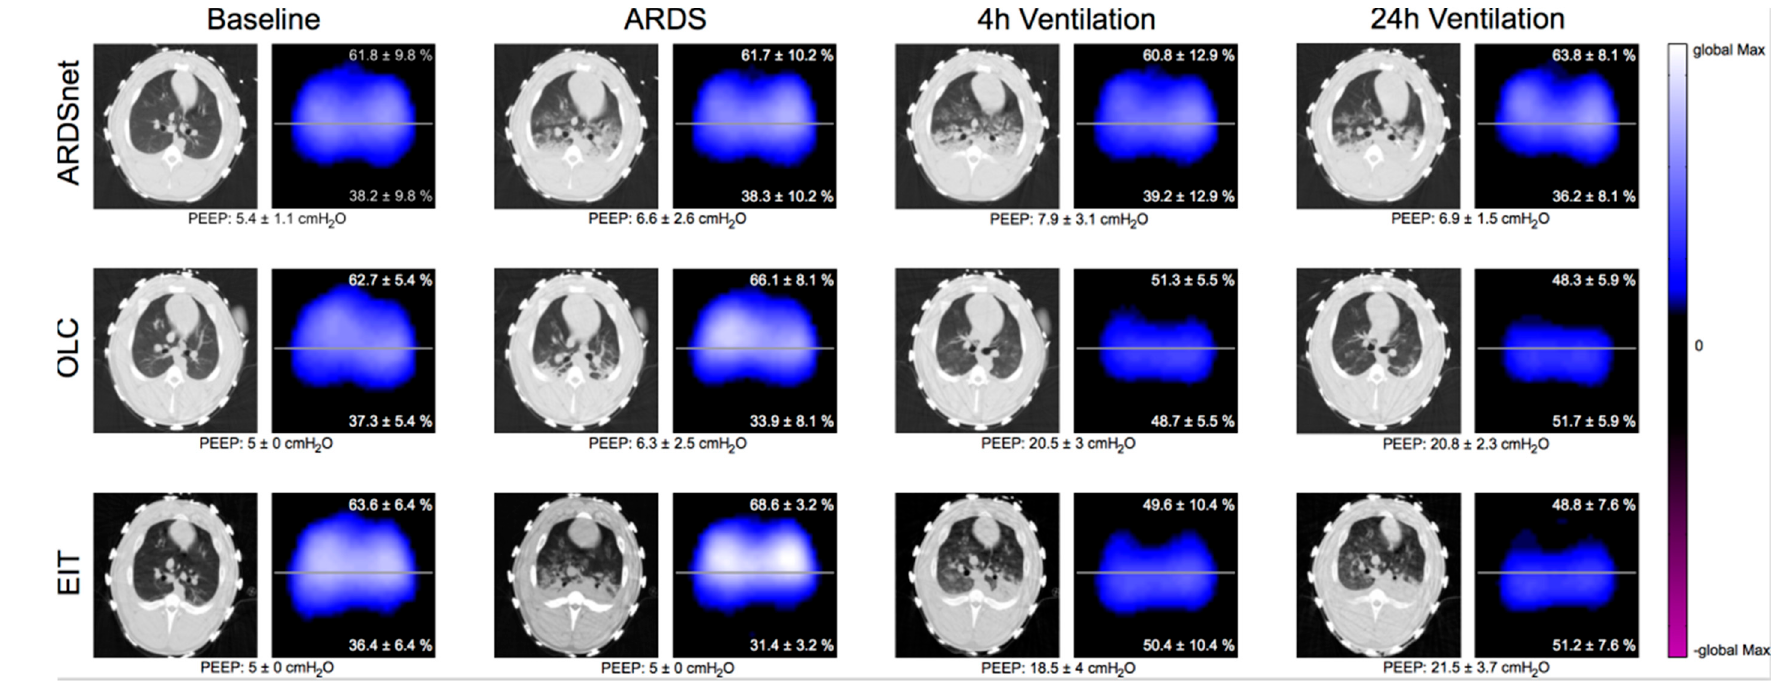
Figure 4. Representative examples of CT- and EIT-images. A derived analysis obtained at baseline, at diagnosis of ARDS, and after 4 and 24 h of mechanical ventilation is presented for each ventilation group (ARDSnet, OLC, and EIT). Representative CT-Images for each group and time point are displayed. For EIT parameter analysis medibus-data (of PEEP) and reconstructed tidal images with Dräger algorithms (Dräger Medical Germany, GmbH, Lübeck, Germany) were used. Percentages for ventral and dorsal distribution of ventilation (positive pixel values) in EIT images were calculated based on tidal images, which were averaged over each group at each point in time for visualization. PEEP data and percentage of ventral and dorsal ventilation are shown as mean with standard deviation for each group and time point.